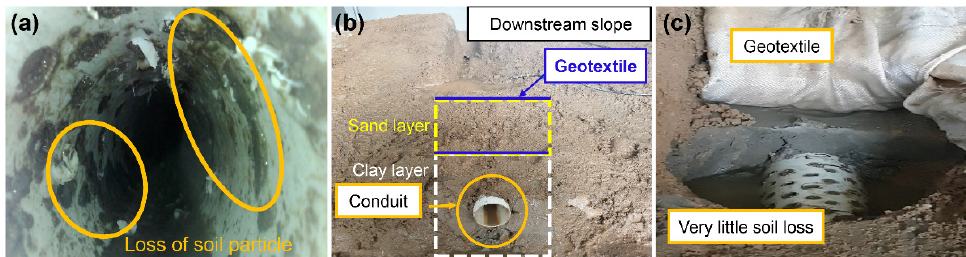
Figure 5. Crack conditions in the improved model (Case 2—Crack): ( a ) modest loss of soil particles in the conduit, ( b ) sand and geotextile layers in the downstream slope, and ( c ) minimal soil loss near the conduit-filling zone.